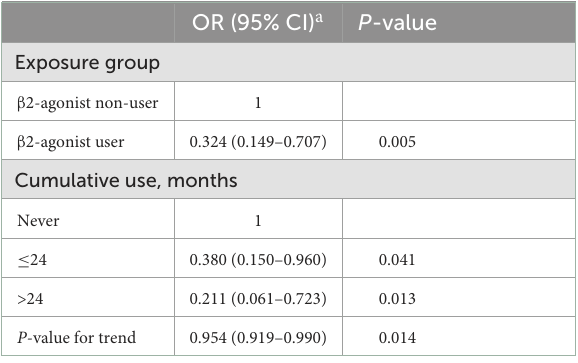
β 2-agonist users β 2-agonist ( N = 98) non-users ( N = 446)